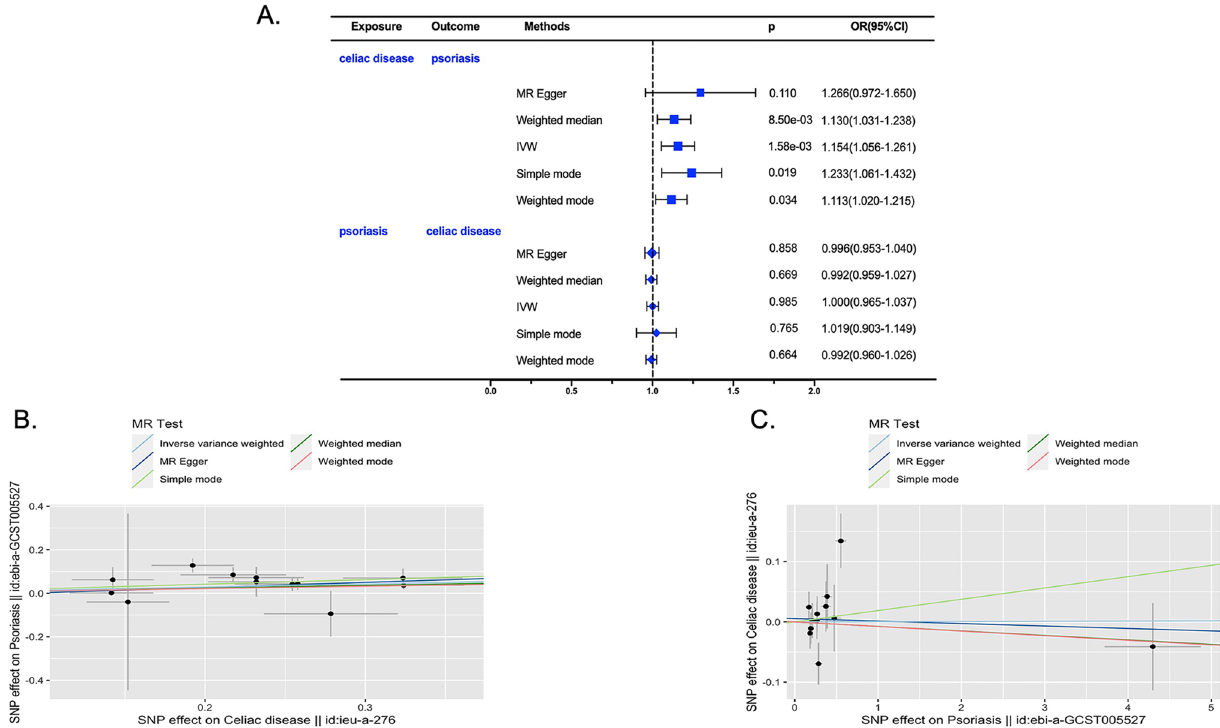
Figure 2. Genetic association between psoriasis and CD using bidirectional 2-sample MR analysis. ( A ) Forest plot summarizing the bi-directional MR results: the effect of CD on psoriasis (upper panel); the effect of psoriasis on CD (lower panel); OR odds ratio; CI confidential interval. IVW inverse variance weighted. ( B ) Scatter plot of the effect of celiac disease on psoriasis; ( C ) Scatter plot of the effect of psoriasis on Celiac